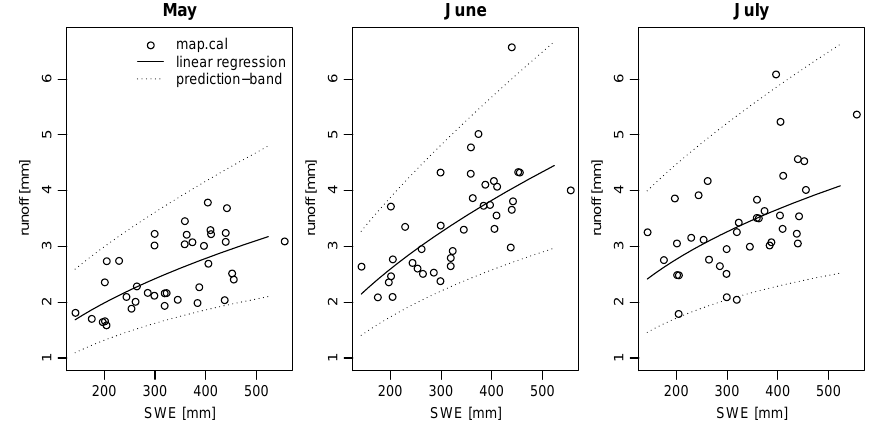
Fig. 14. The minimum runoff of the Rhine River gauge in Neuhausen in May (left), June (middle) and July (right) explained by the SWE on 15 April. The linear regression is computed based on the log-transformed runoff and SWE variables and is then back-transformed to the non-logarithmic space. SWE (black circles) are based on map.cal. The black line is the linear regression line. The dotted line marks the prediction